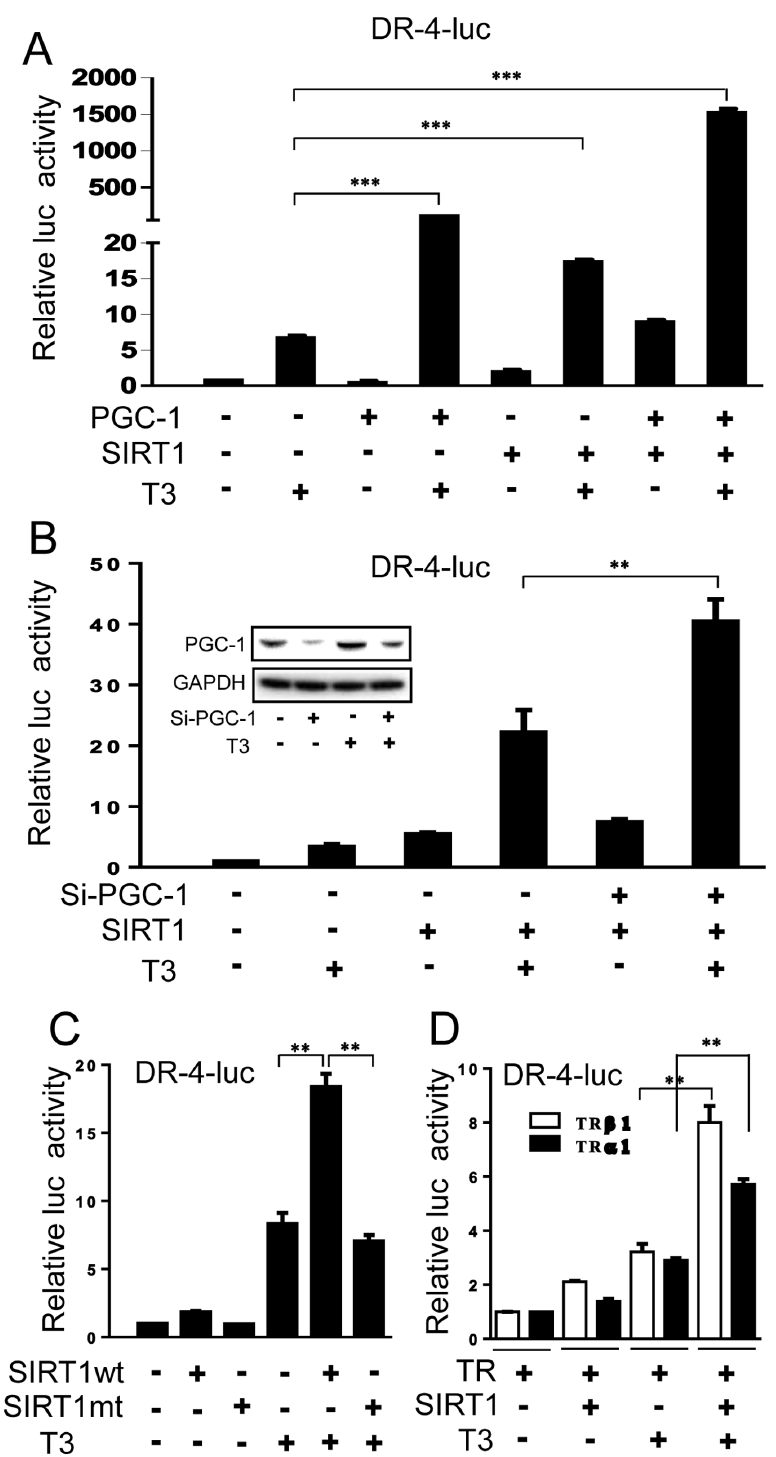
Figure 1. SIRT1 is a TR b 1 co-regulator. ( A ) Graph representing luciferase activity measured in extracts of HepG2 TR b 1 cells transfected with DR-4- luc and expression vectors for PGC-1 a , SIRT1 or both and treated + / 2 T 3 . ( B ) Results of luciferase assay in HepG2 TR b cells when siRNA against PGC- 1 a is used. Inset represents a western blot of cell extracts using PGC-1 a antibody to confirm PGC-1 a knockdown. ( C ) As in Fig. 1B, but using expression vectors for wild type SIRT1 and deacetylase defective mutant of SIRT1 (H355Y). ( D ) Luciferase activity measured in 293T cells transfected with expression vectors for TR b 1 or TR a + / 2 SIRT1 expression vector and treated + / 2 T 3 . The levels of luciferase activity were normalized to lacZ expression. All data are representative of at least three independent experiments with similar results. All values represent the mean 6 SD of duplicate samples. ***, P , 0.001; **, P , 0.01.